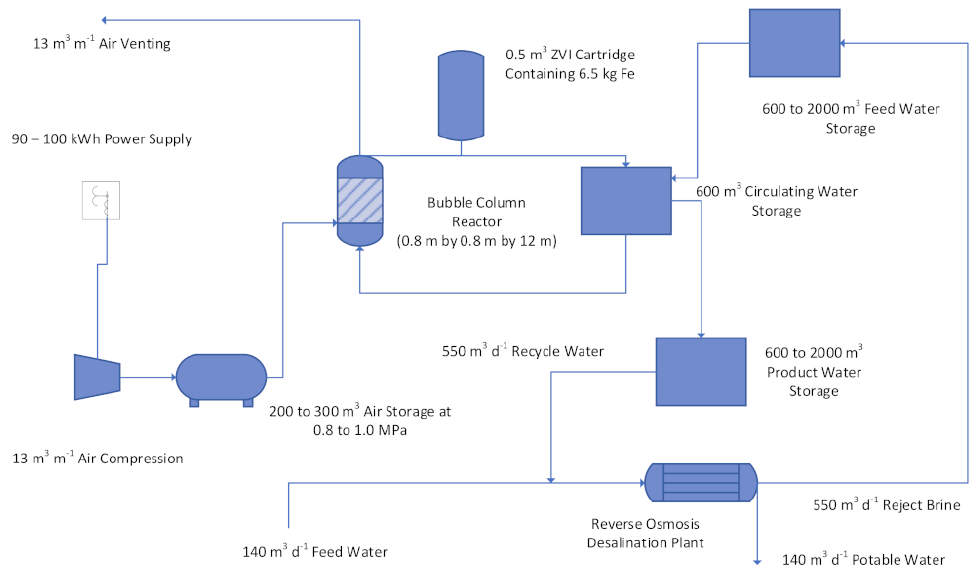
Figure 9. Expected plant layout associated with a 650 train reactor, processing 550 m 3 d − 1 (200,750 m 3 a − 1 ) and designed to handle the reject brine associated with a reverse osmosis de- salination